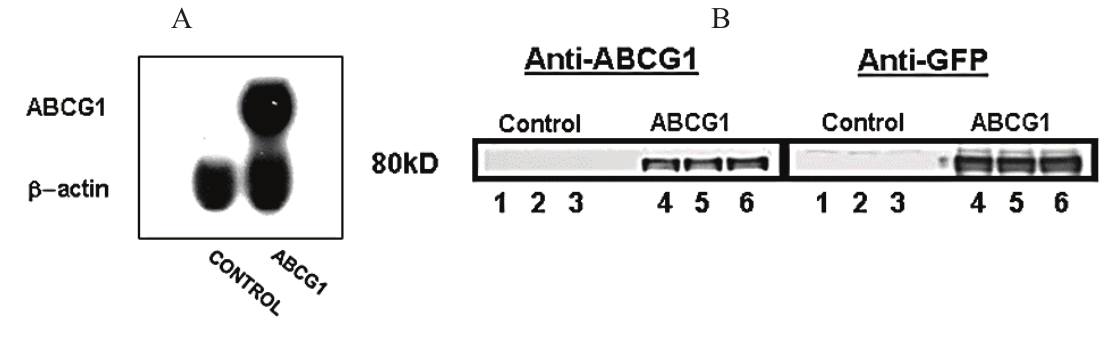
Figure 1. Stable expression of ABCG1-GFP in a HeLa cell line. ( A ) Northern blot analysis of control and ABCG1-GFP stably transfected HeLa cells. ABCG1-GFP is robustly expressed in the stably transfected HeLa cell line in the absence of endogenous ABCG1 expression; ( B ) Western blot analyses of control and ABCG1-GFP stably transfected HeLa cells. An 80 kD protein is recognized by antibodies against both GFP and the N-terminus of ABCG1 in stably transfected HeLa cells but not control HeLa cells, confirming ABCG1-GFP expression in the absence of endogenous ABCG1